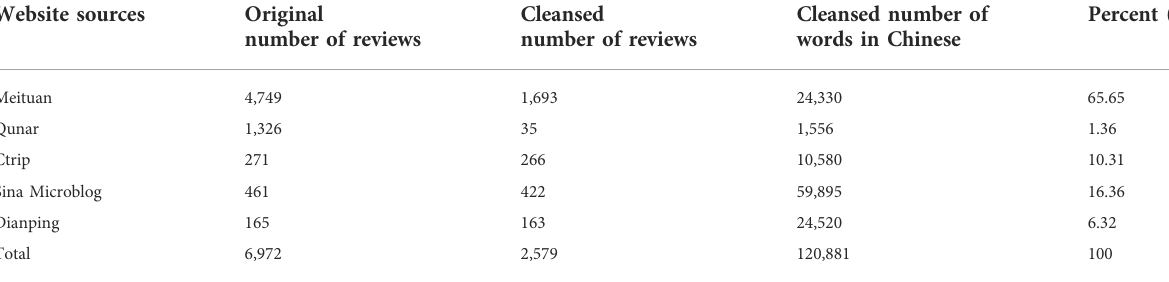
TABLE 1 The original and cleansed number of reviews for further interpretation after